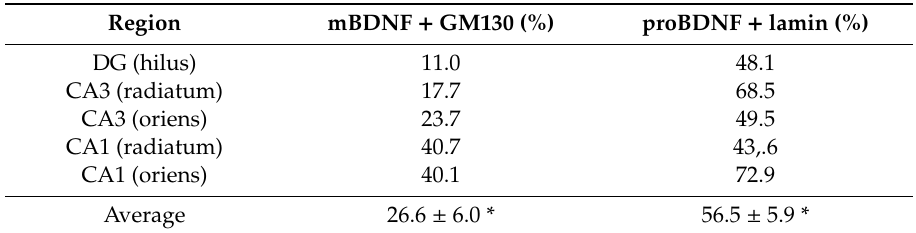
Table 1. Overlap of mBDNF with GM130 and proBDNF with lamin signal detected in immunolabeled hippocampal YFP +